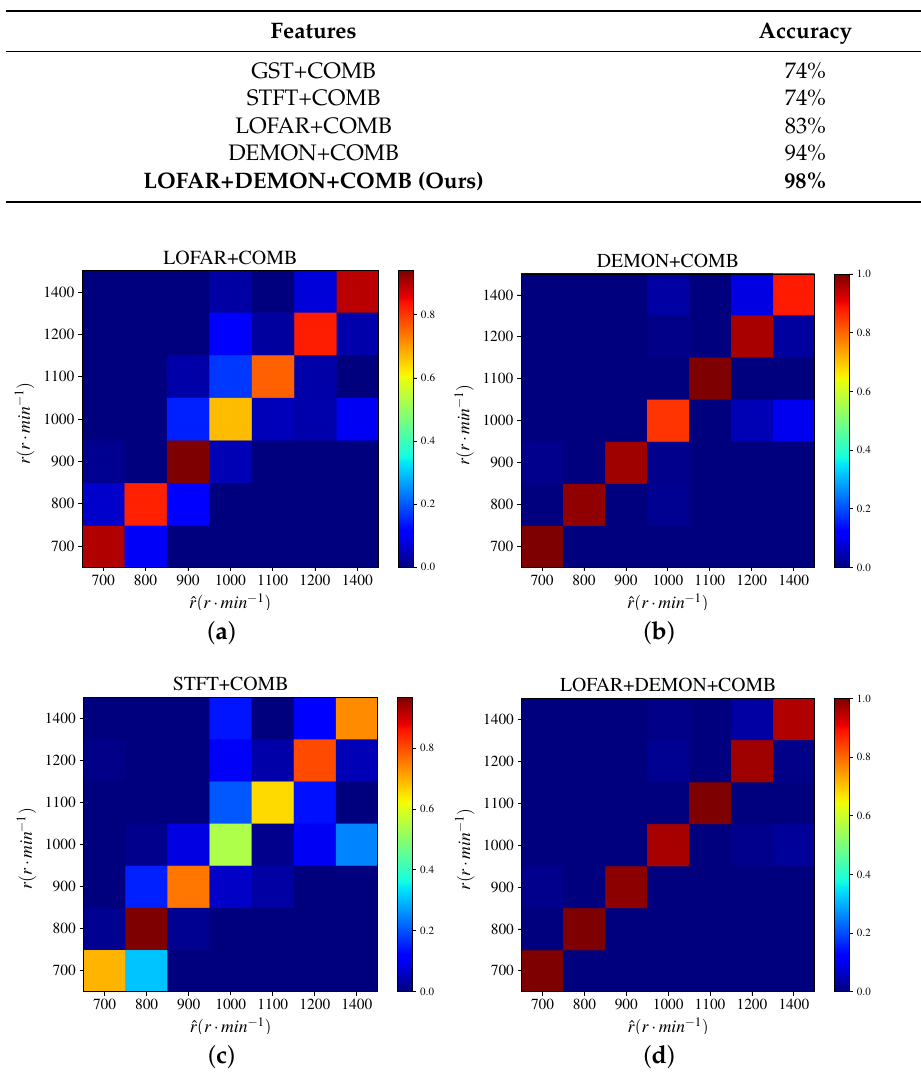
Figure 13. The confusion matrix of different features for F 0 estimation on the lake trial dataset (COMB included). The GST is neglected since it has the same overall accuracy as STFT ( c ). ( a , b , d ) represent the cofusion matrix when LOFAR, DEMON and LOFAR+DEMON are employed for classification,